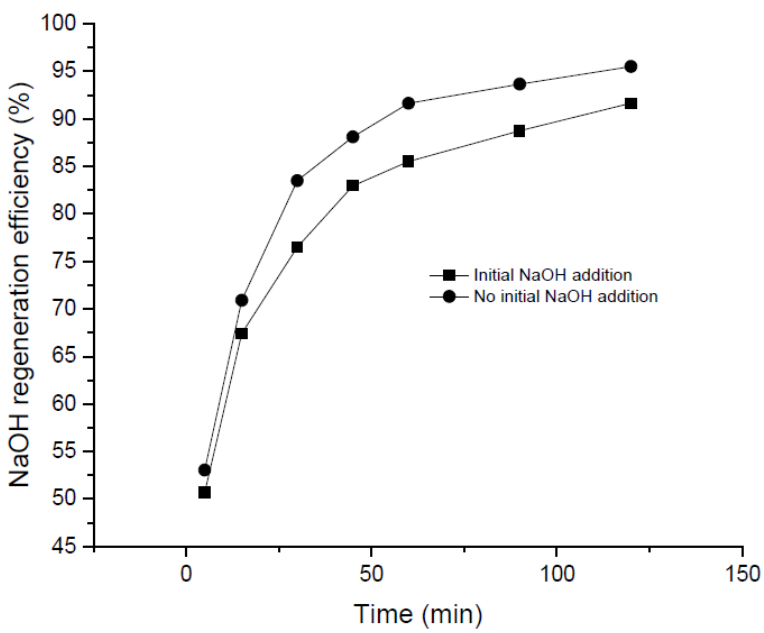
Figure 5. Comparison curves of NaOH regeneration efficiency with and without initial addition of